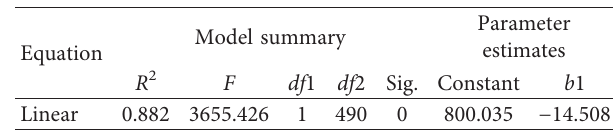
Table 3: Model summary and parameter estimates for